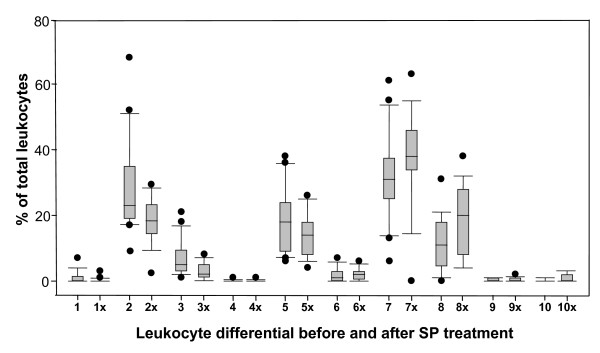
Leukocyte differential counts before and seven days after SP treatment. One hundred leukocytes on fingerprick peripheral blood smear slides for each child made before and seven days after SP treatment (x) were classified into one of ten groups. The percentage of each group was calculated. Box plots indicating the 25th, 50th, and 75th percentile (solid lines from bottom to top of box, respectively), the 90th and 10th percentile values (high and low error bars respectively), and high and low outlier points are shown for each of the following leukocyte classes: 1) metamyelocytes, 2) segmented neutrophils, 3) bands, 4) hypersegmented neutrophils, 5) NETs, 6) monocytes, 7) lymphocytes, 8) smudge forms, 9) eosinophils, and 10) basophils.